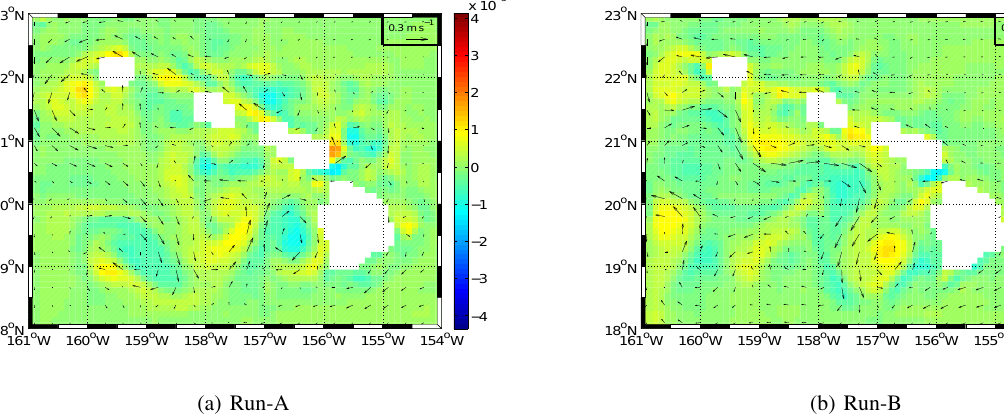
Fig. 4. Relative vorticity field with velocity vectors at 10-m depth on 22 August for Run-A (left) and Run-B (right).